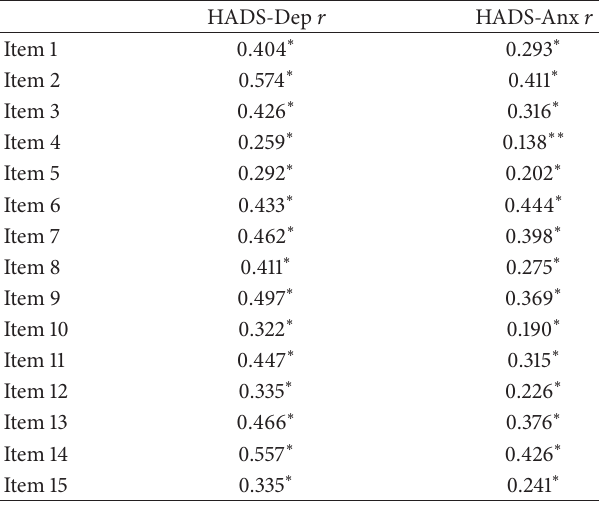
Table 5: Correlation between the specific cognitive distortions and measures of mood